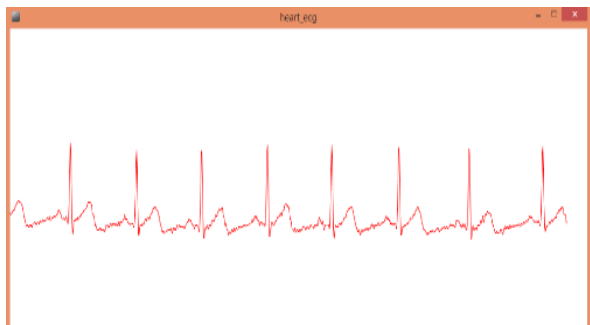
Figure 10. ECG wave at the receiving